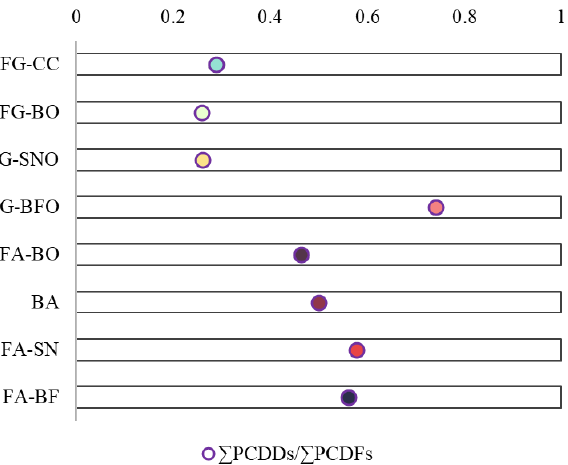
Figure 5. Ratios for total concentrations of PCDDs to PCDFs in leather waste incineration.